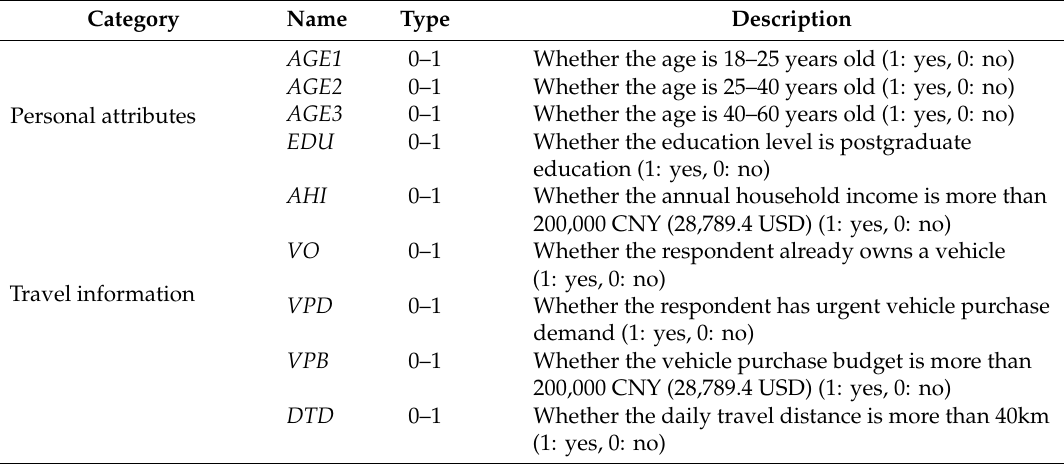
Table 2. Description of basic variables. EDU = education, AHI = annual household income, VO = vehicle ownership, VPD = vehicle purchase demand, VPB = vehicle purchase budget, and DTD = daily travel distance.